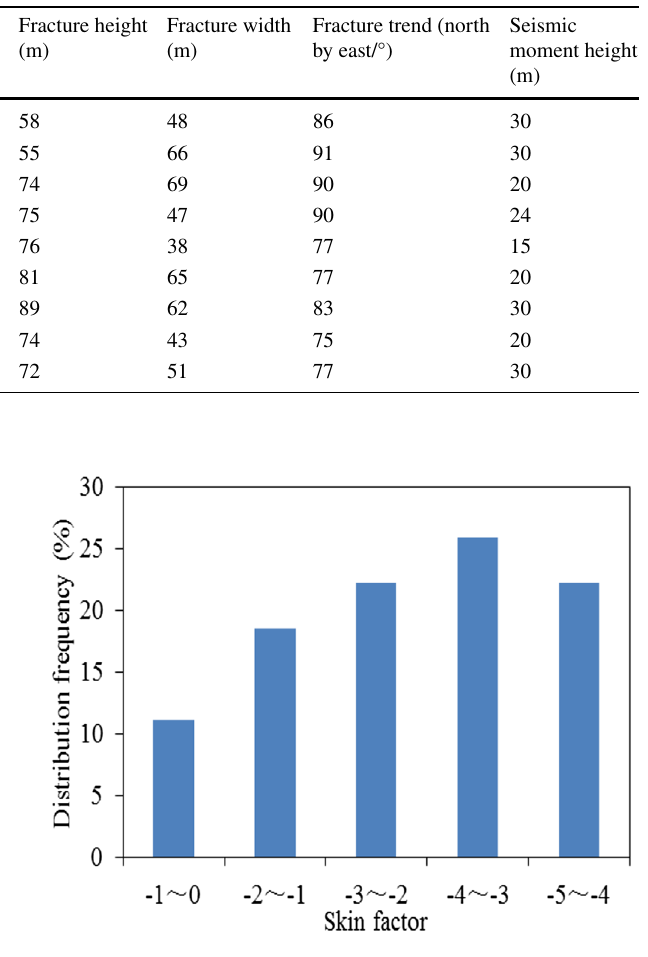
Fig. 3 Distribution frequency of skin factor obtained from the